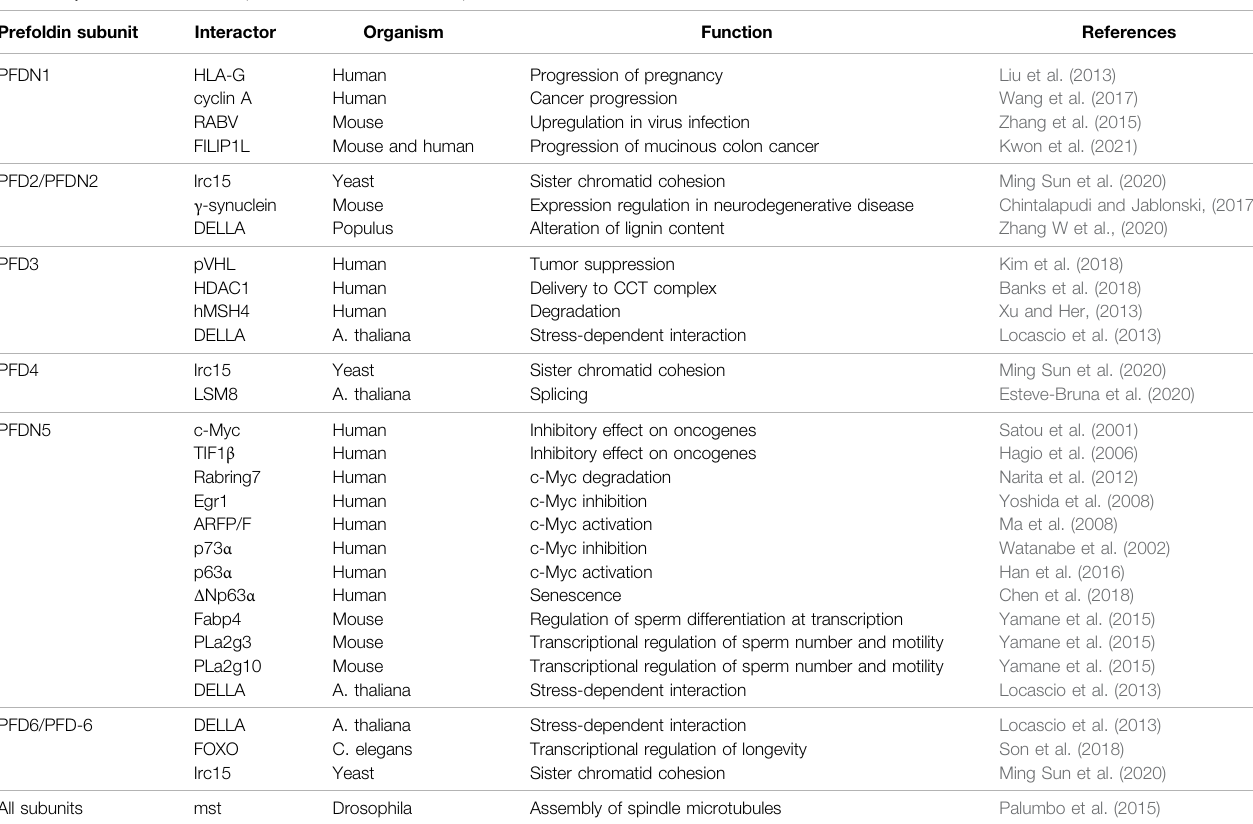
TABLE 1 | Interactions between prefoldin subunits and other proteins. Prefoldin